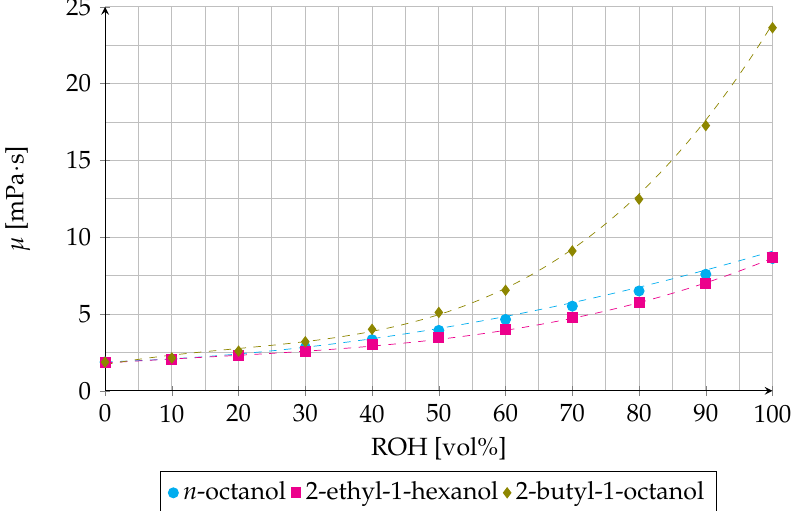
Figure 4. Effect of alcohol (ROH) concentration on the viscosity of n-octanol, 2-ethyl-1-hexanol and 2-butyl-1-octanol diluted in kerosene. Table 2. Solubility of n -octanol (1) , 2-ethyl-1-hexanol (2) , 2-butyl-1-octanol (3) , 2-octanol (4) , and